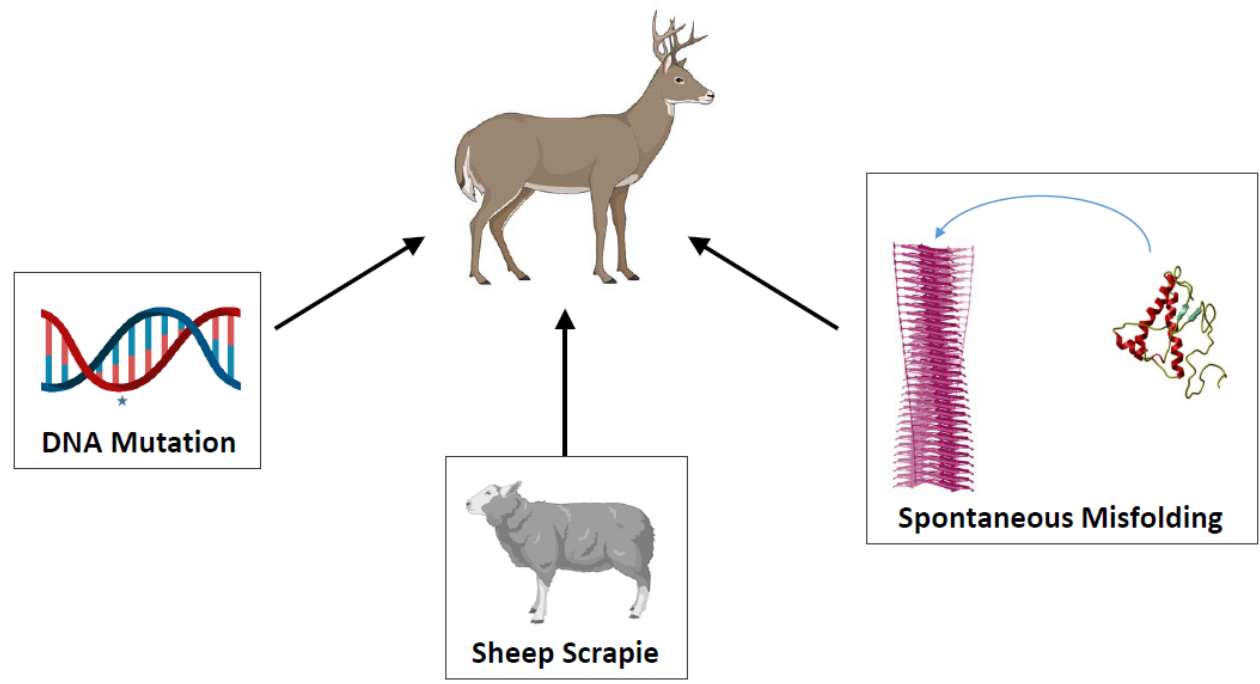
Figure 1. Schematic representation of the different hypotheses to explain the CWD origin. Although the origin of CWD is largely unknown, various hypotheses have been proposed, including transmission from a scrapie-infected sheep, a mutation in the Prnp gene (illustrated as a star in the left panel) and a spontaneous misfolding of PrP C into PrP Sc.